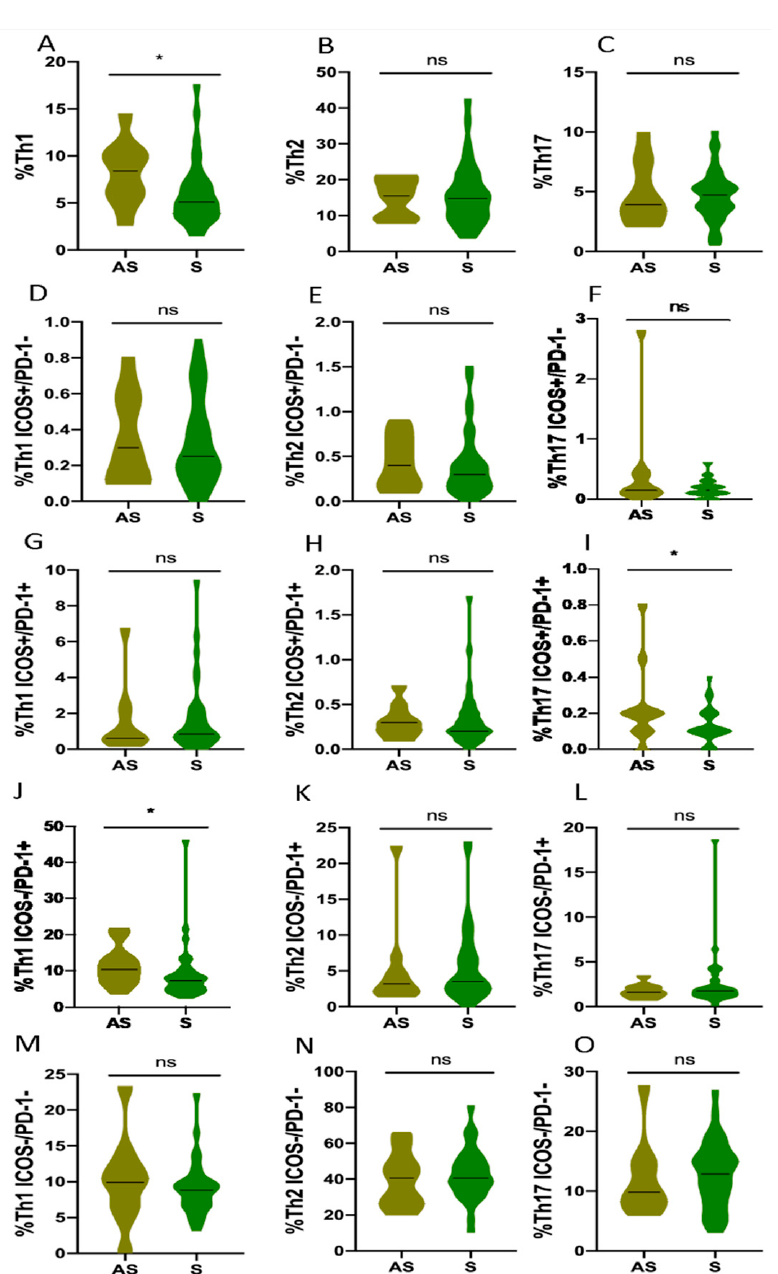
Figure 6. Th subsets in asymptomatic and symptomatic COVID-19 patients without hospitalization requirements. ( A ) Total percentage of Th1 CD4+ T cells ( B ) Total parentage of Th2 CD4+ T cells ( C ) Total percentage of Th17 CD4+ T cells ( D ) Percentage of early-activated (ICOS+/PD-1-)Th1 CD4+ T cells E Percentage of early-activated (ICOS+/PD-1-)Th2 CD4+ T cells ( F ) Percentage of early-acti- vated (ICOS+/PD-1-)Th17 CD4+ T cells ( G ) Percentage of late-activated (ICOS+/PD-1+)Th1 CD4+ T cells ( H ) Percentage of late-activated (ICOS+/PD-1+)Th2 CD4+ T cells ( I ) Percentage of late-activated (ICOS+/PD-1+)Th17 CD4+ T cells ( J ) Percentage of senescent (ICOS-/PD-1+)Th1 CD4+ T cells ( K ) Percentage of senescent (ICOS-/PD-1+)Th2 CD4+ T cells ( L ) Percentage of senescent (ICOS-/PD- 1+)Th17 CD4+ T cells ( M ) Percentage of quiescent (ICOS-/PD-1-)Th1 CD4+ T cells ( N ) Percentage of